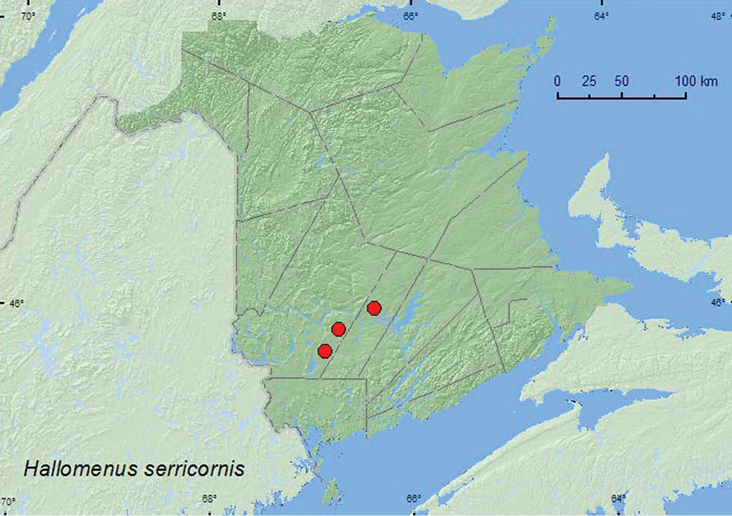
Collection localities in New Brunswick, Canada of Hallomenus serricornis.